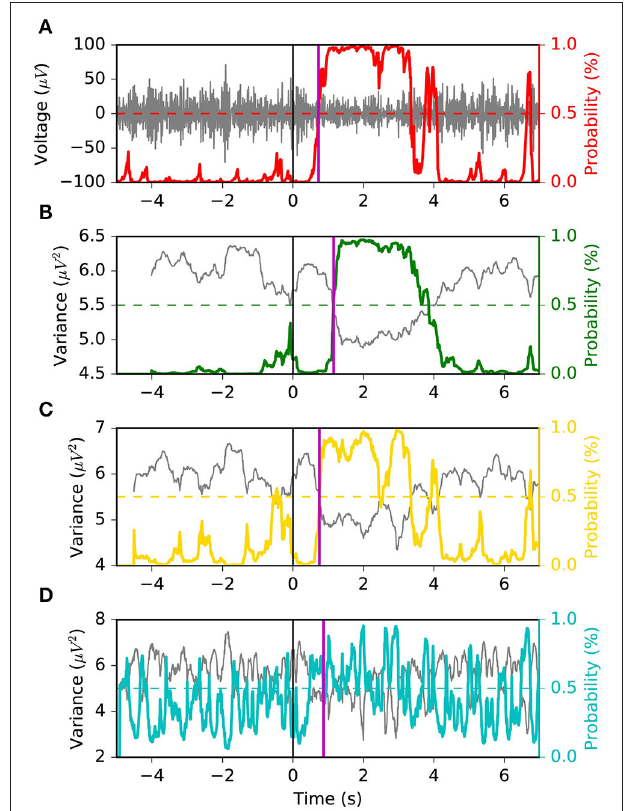
FIGURE 7 | Example 2 of the typical behavior of the four models. This example is taken from a subject performing foot motor imagery. The MSM achieves the best tradeoff between latency, FPR and G-mean. Panel (A) shows the EEG voltage obtained after CSP spatial filtering in gray and the MSM model output in red. Panels (B–D) represent the decoding associated with sliding window lengths 1.0, 0.5, and 0.1 s, respectively. This figure follows the same convention as in Figure 1